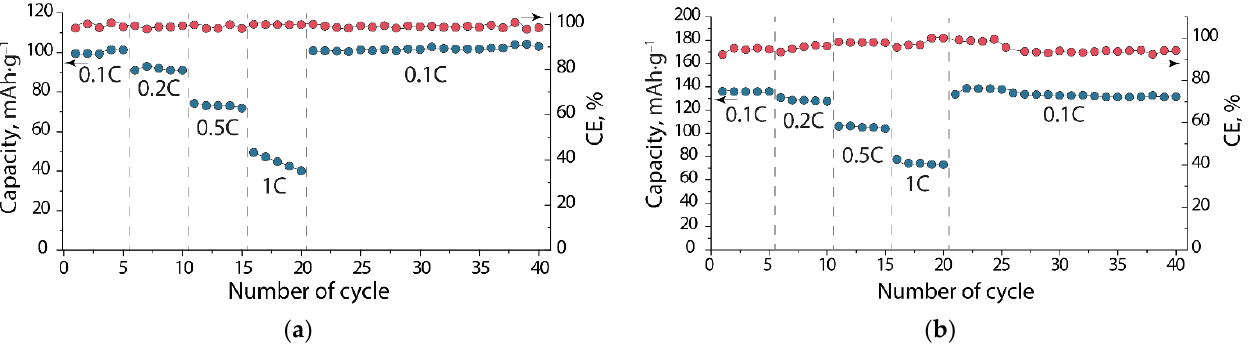
Figure 9. Coulombic efficiency (red dots) and discharge capacity (blue dots) of LFP|Li cell with ( a ) SSEBS-Ph-EC-DMA and ( b ) 1M LiClO 4 in an EC-DMC mixture electrolyte at different C-rates.